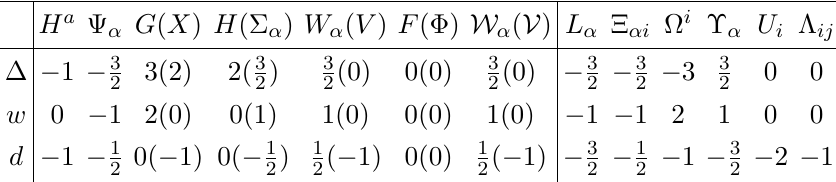
Table 2 . Weyl ((cid:1)) weight, U(1) R ( w ) weight, and engineering dimension of various (cid:12)elds and pa- rameters.